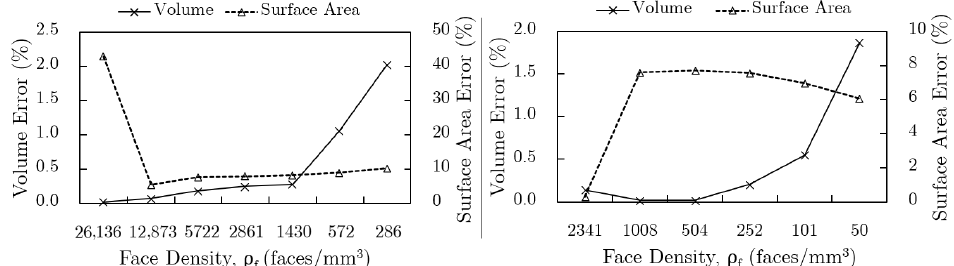
Figure 10. Error of the volume and surface area with respect to the density of faces for the closed-cell foam ( left ) and the cubic open-cell foam ( right